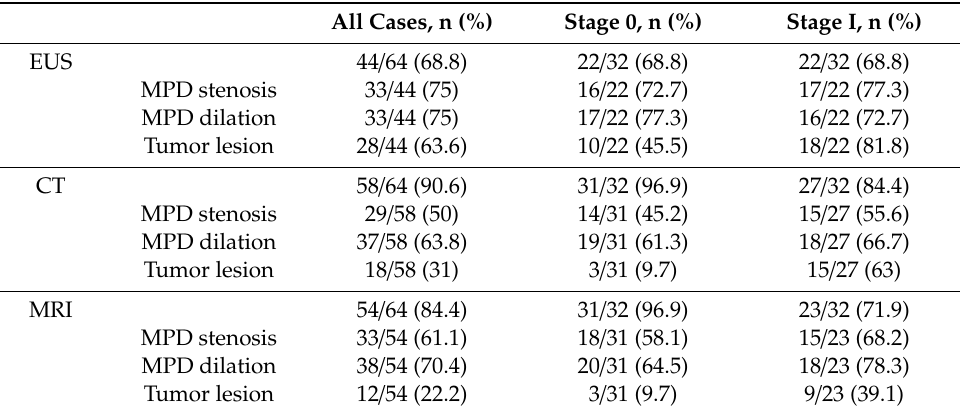
Table 3. Imaging findings of stage 0 and stage I PC.